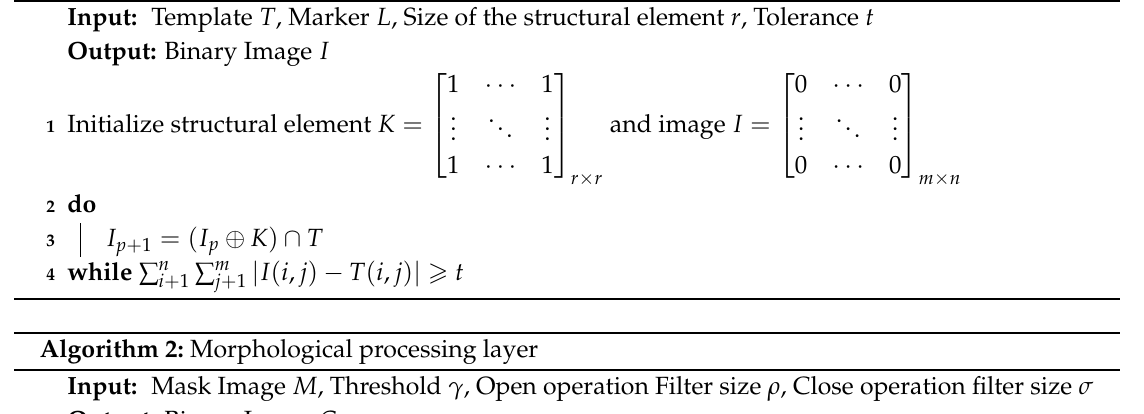
Algorithm 1: Morphological reconstruction